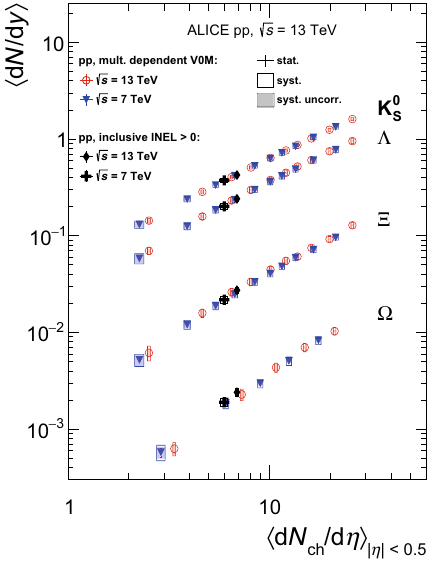
Fig. 11 Integrated yields of K 0 , (cid:3) , (cid:4) , and (cid:5) as a function of d N ch / d η √ S s = 7 and 13 TeV. Statisti- in V0M multiplicity event classes at cal and systematic uncertainties are shown by error bars and empty boxes, respectively. Shadowed boxes represent uncertainties uncor- related across multiplicity. The corresponding results obtained for INEL > 0 event class are also